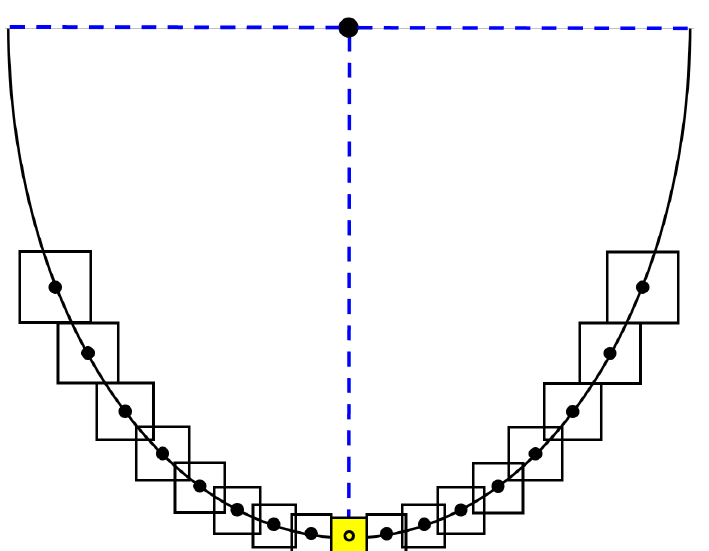
Figure 7. Extension from the center skeleton pixel to both sides and retracting to approximate the curvature of an ellipse. The edge lengths of the particles increase linearly from the center to the sides. The yellow pixel is the skeleton